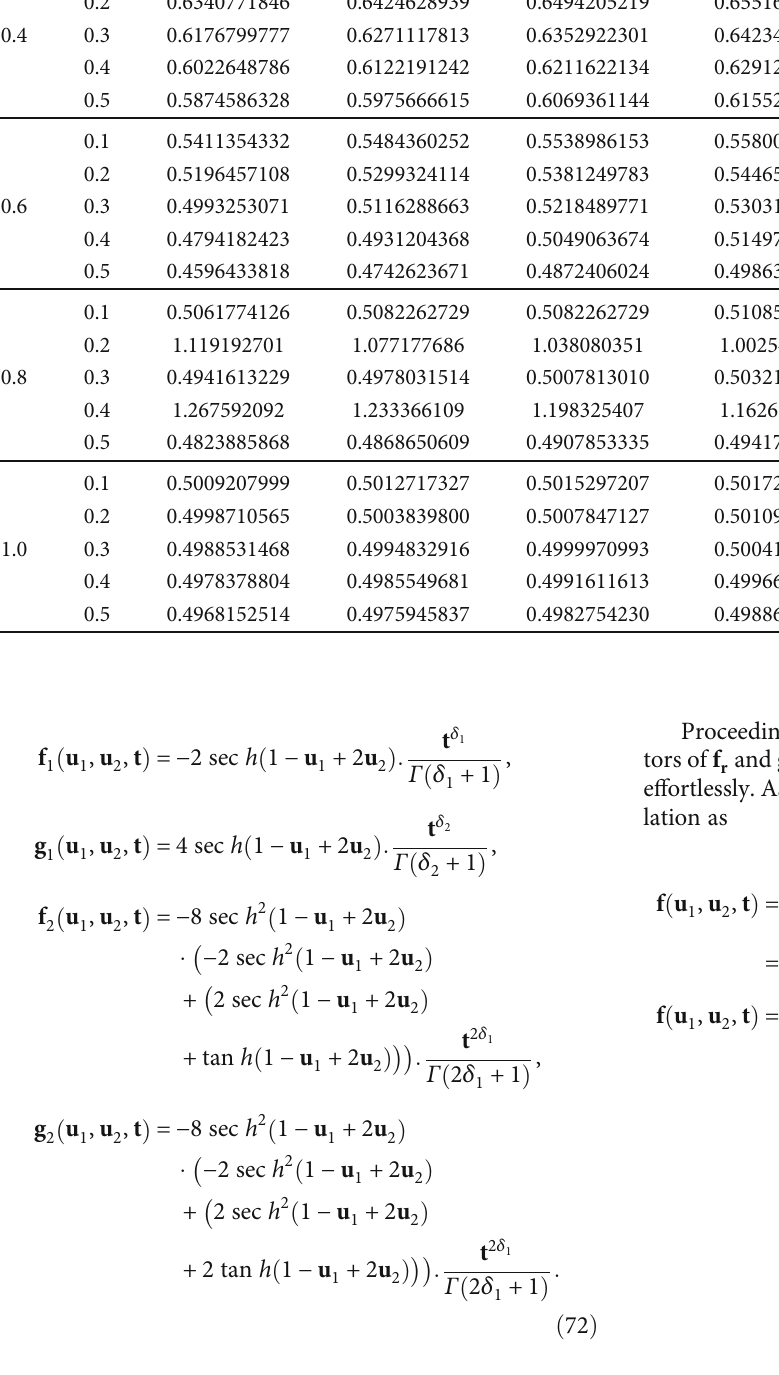
JTDM , u , t Þ of Example 16 for multiple fractional orders considering di ff erent values C and ABC solutions of f ð u 1 2